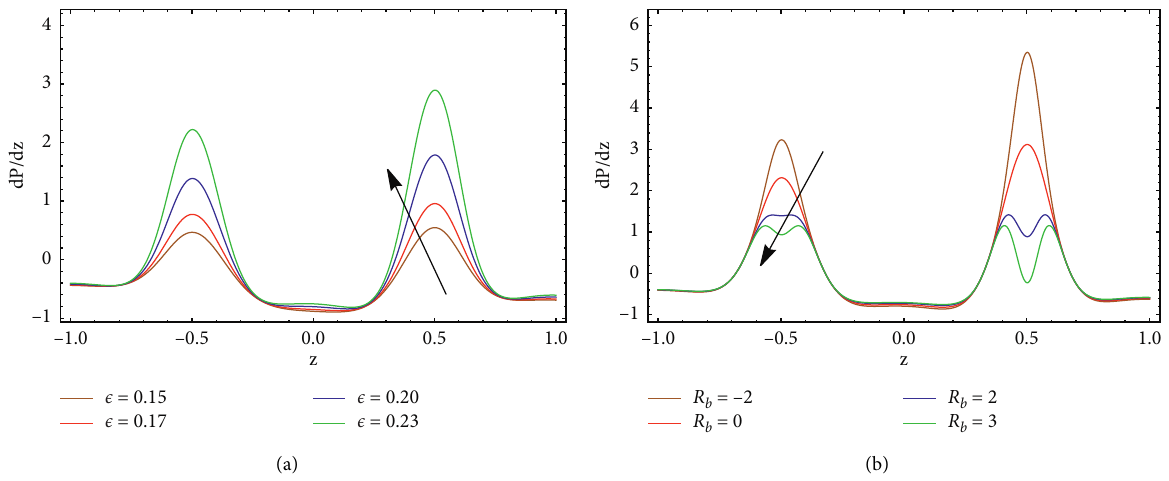
Figure 6: The variation of pressure gradient d P /d z for different values of ε and R